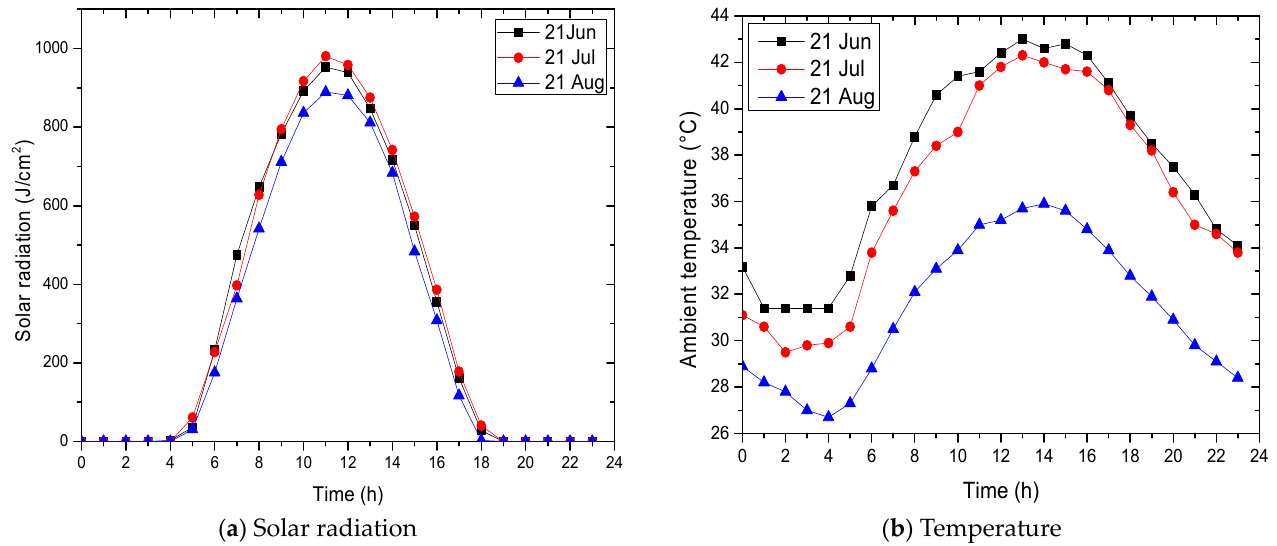
Figure 6. Instantaneous variation of solar radiation and ambient temperature (Ghardaïa site).